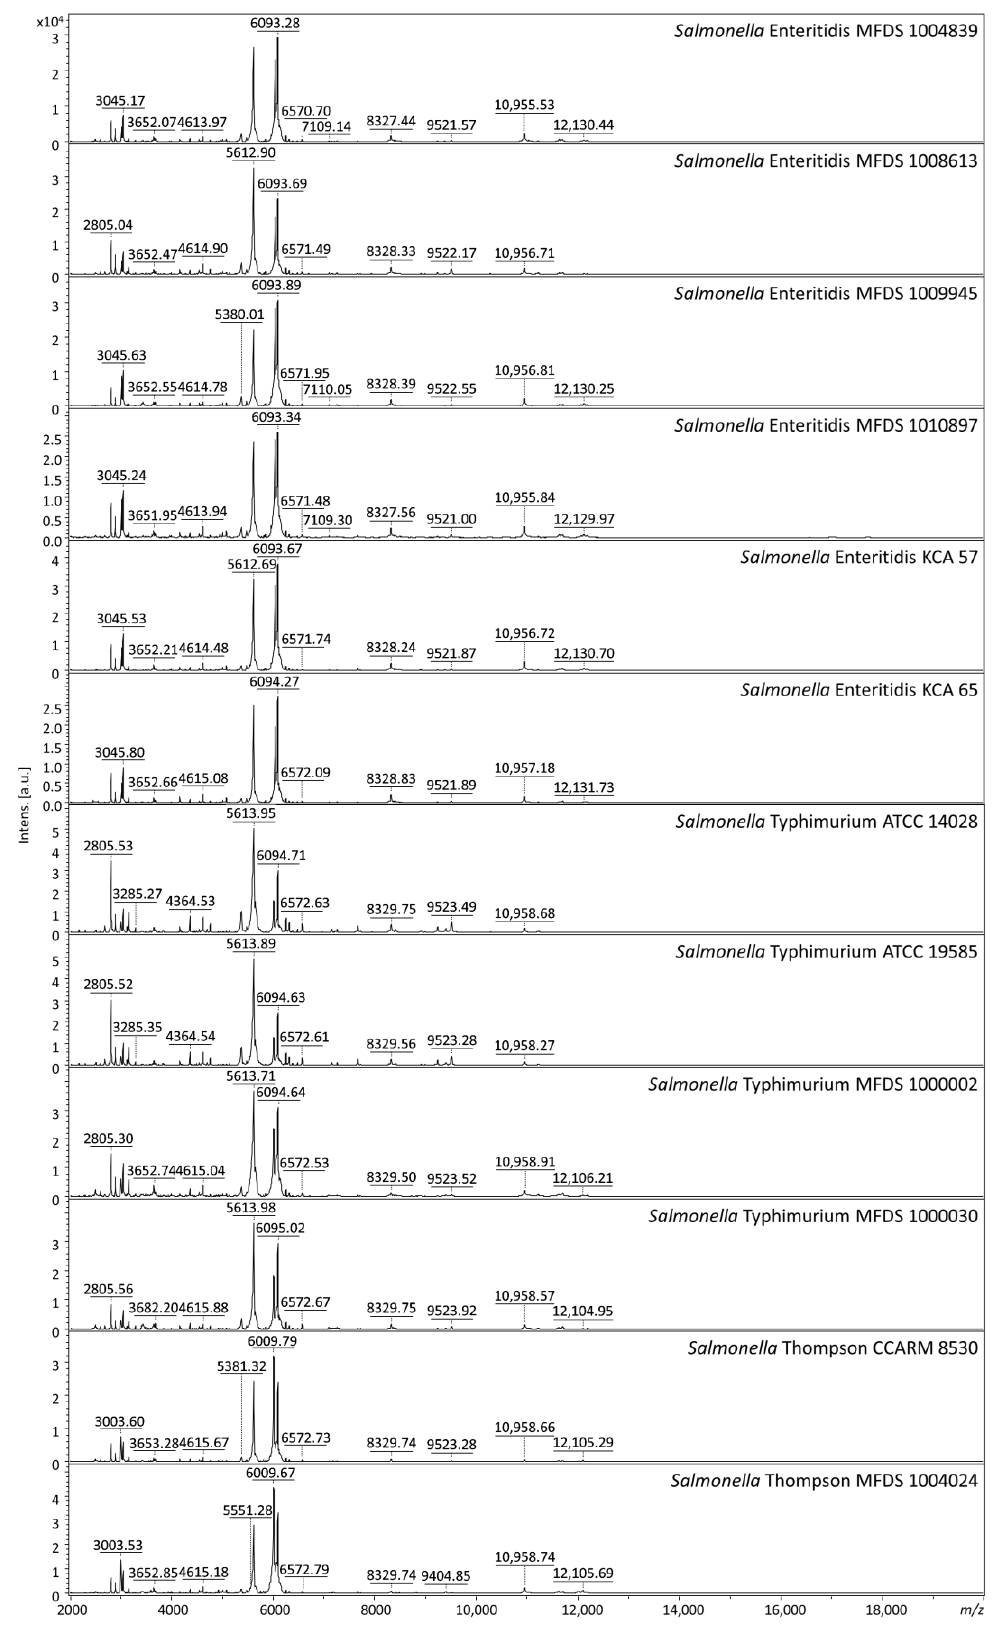
Figure 3. MALDI – TOF MS spectra of reference strains of serovars Enteritidis, Figure 3. MALDI–TOF MS spectra of reference strains of serovars Enteritidis, Typhimurium, and Thompson; m/z , mass-to- Typhimurium, and Thompson; m/z , mass-to-charge ratio; a.u., arbitrary units. charge ratio; a.u., arbitrary